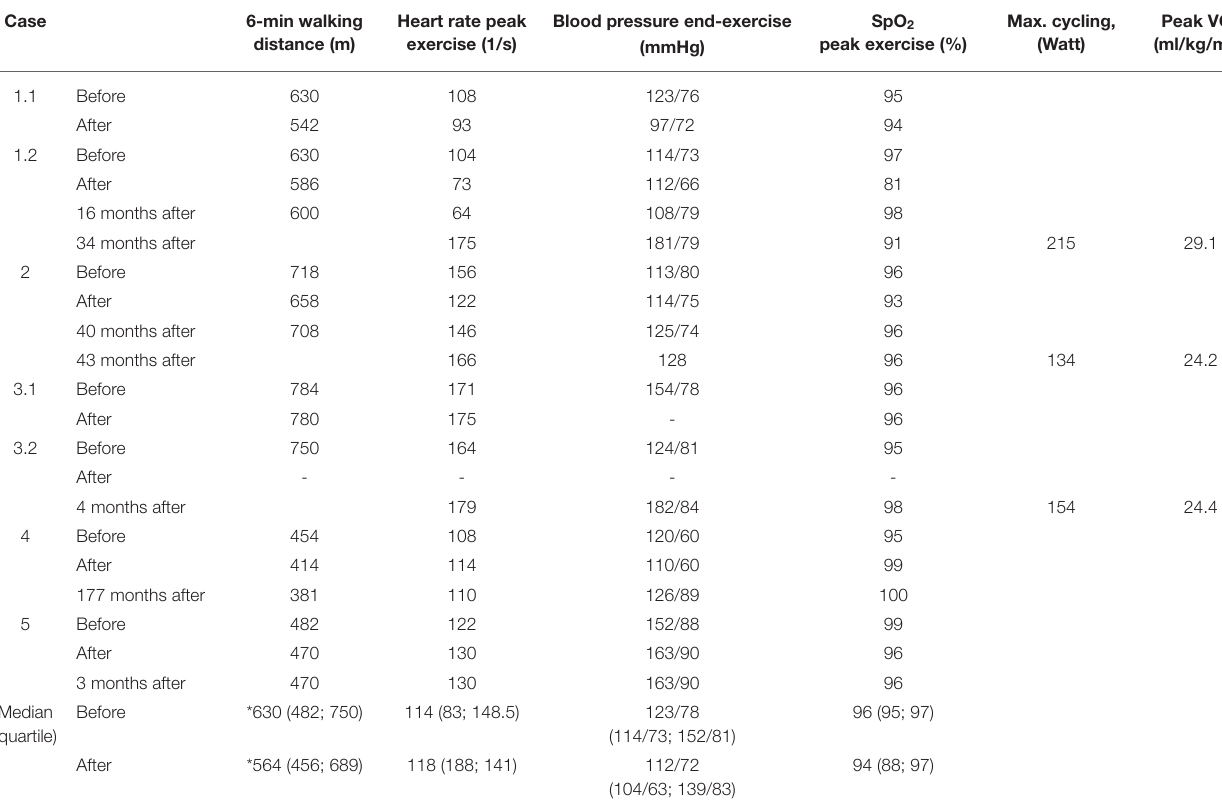
TABLE 4 | Six-min walking distance before and 3–6 month after pregnancy and at follow-up such as results of last cardiopulmonary exercise testing.